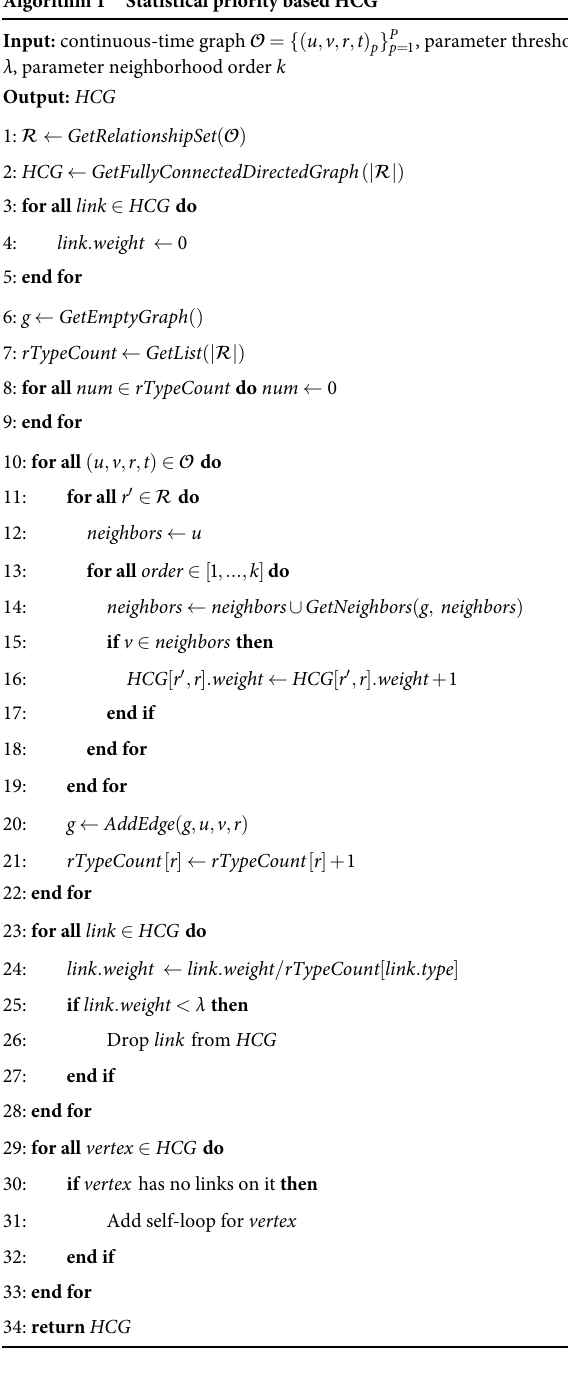
Fig. 3a. The intuitive construction of embedding vectors for